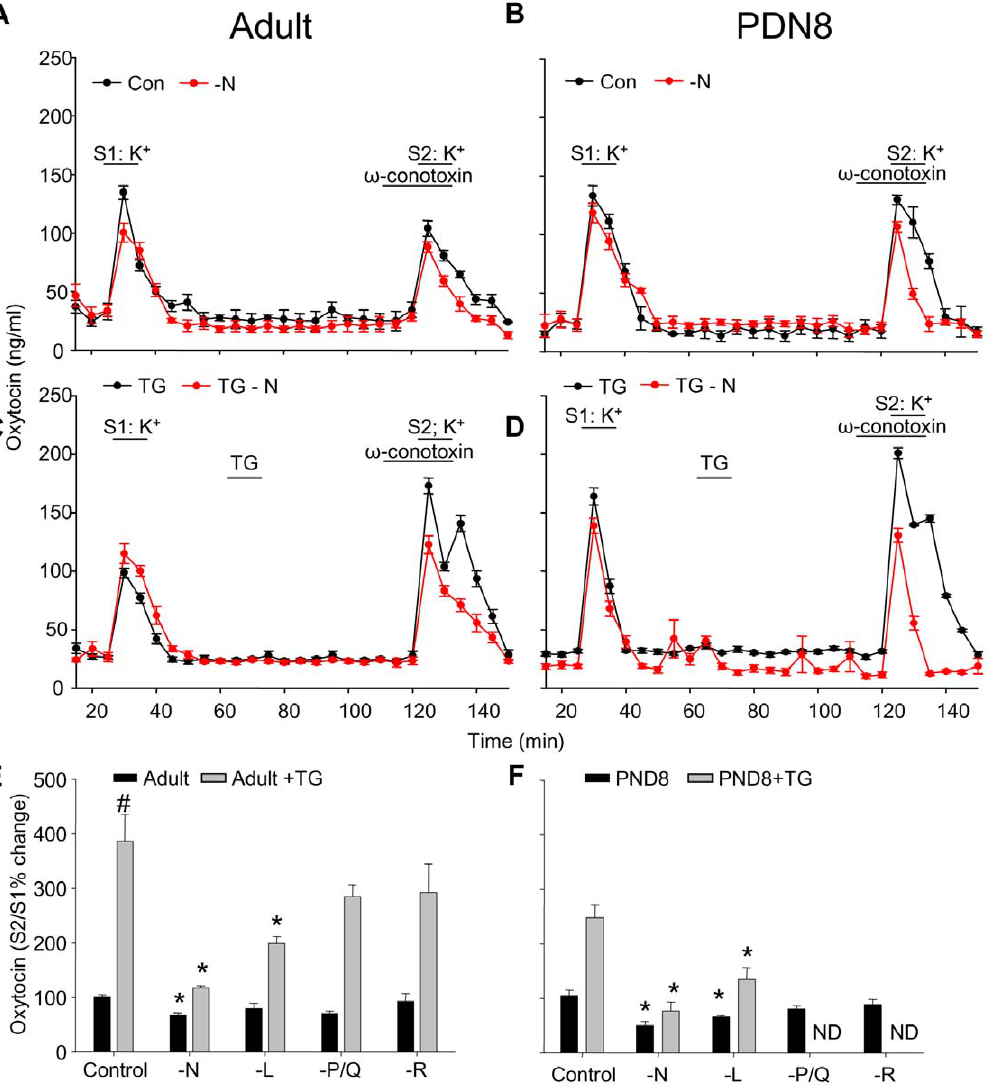
Figure 1. Effects of VOCC toxins on oxytocin release from SONs invitro. Blocking N-type VOCC in SONs from adult ( A ) PDN-8 (B), thapsigargin- (TG)-treated adult rats ( C ) and TG-treated PDN-8 rats (D) shows a decrease in amplitude and duration of the potassium stimulated response. Stimulated release was enhanced after pretreatment with 0.2 m M TG as previously described ( C D black lines) (Ludwig et al., 2002); this was prevented by blocking N-type Ca 2 + channels (red lines). Effects of blocking different VOCC on the S2:S1 oxytocin response in SONs from adult and adult TG-treated rats (E) and PND-8 rats and TG-treated PDN-8 rats ( F ). Means 6 S.E.M., n =6 per group, # P , 0.05 vs first S1, * P , 0.05 vs control, one- way ANOVA followed by Dunn’s post-hoc